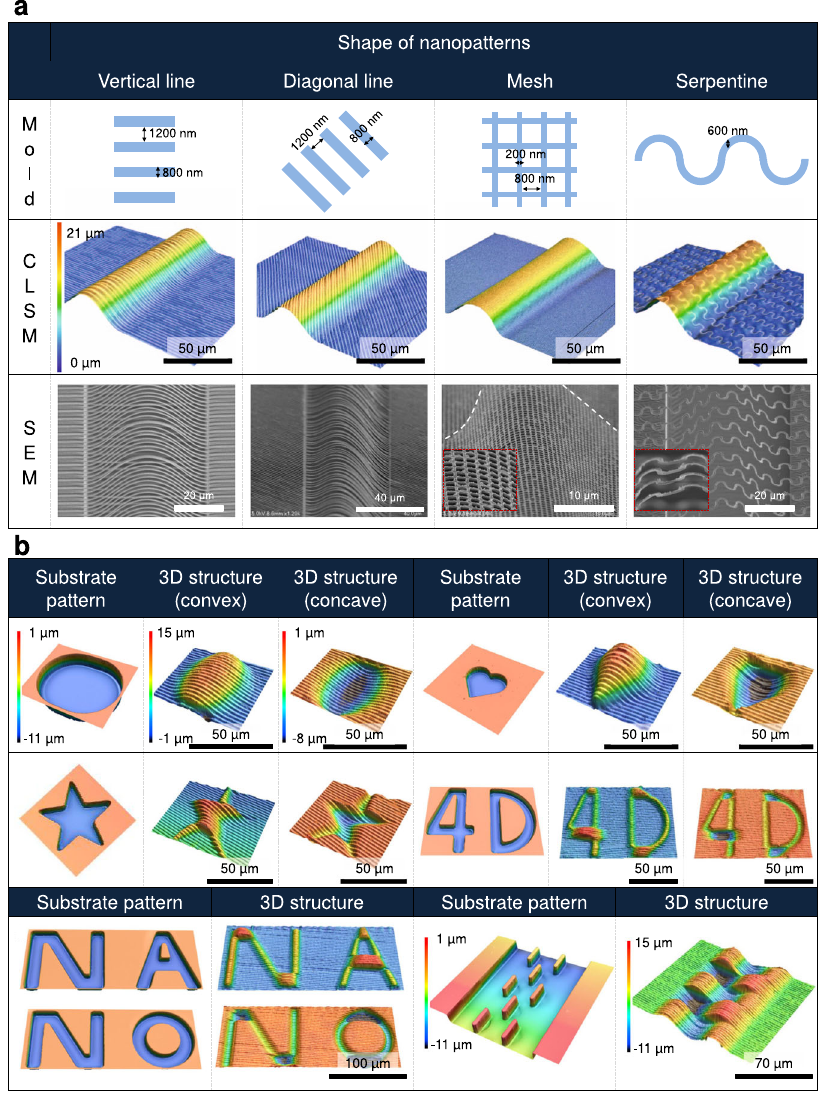
Fig. 4 | Results of mechanically guided assembly – based 3D fabrication under various conditions. a Schematic illustration of precursor two-dimensional nano- patterns (e.g., verticallines, diagonallines, mesh, and serpentine) and microscopic images of three-dimensional nanostructures printed using the corresponding nanopatterned molds. A white dashed line in nanomesh pattern is used to better visualize the curvature of the nanomesh caused by buckling. b Confocal laser scanning microscopy images of elastomer substrates with different micropatterns and corresponding images of three-dimensional nanostructures printed on these